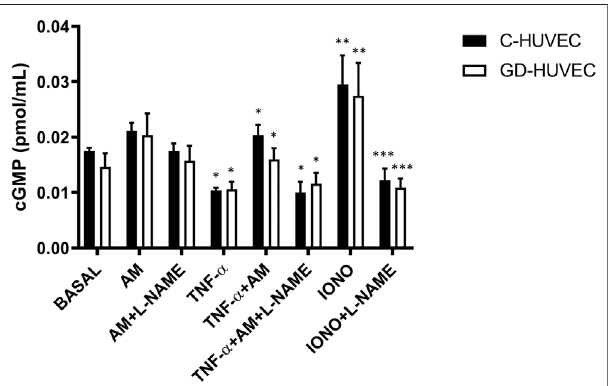
FIGURE4| EffectofAMonintracellularcGMPlevelsmeasuredbyELISA in untreated (basal) and TNF- α -stimulated C- and GD-HUVECs after preincubationfor24 hwithAM.Ionomycin(2 μ M,24 h)wasusedasapositive control. L -NAME (1 mmol/L) was added 45 min before AM and Ionomycin. Data are expressed as pmol/well and results by mean ± SEM, n = 4. ANOVA and Tukey ’ s multiple comparison test: * p < 0.05 TNF- α vs. basal;